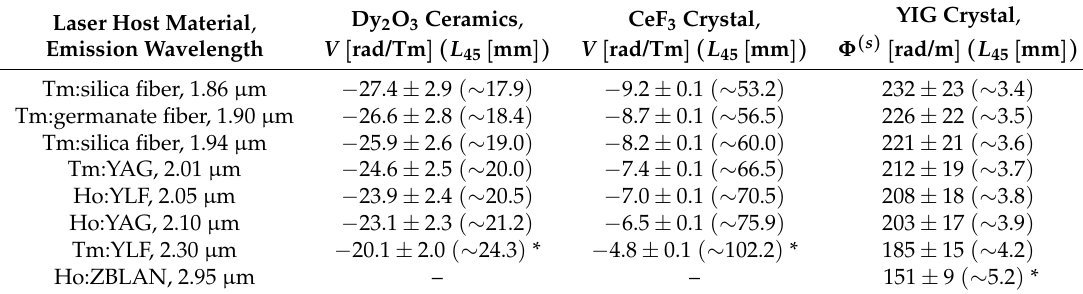
Table 4. Verdet constant and specific Faraday rotation values of the Dy 2 O 3 ceramics, CeF 3 and YIG crystals as given by the obtained models at various emission wavelengths corresponding to several yet-reported mid-IR lasers [1,9]. An L 45 length of a magneto-optical element needed for a 45-degree polarization plane rotation is specified in the brackets for all of the investigated materials. * These values have been